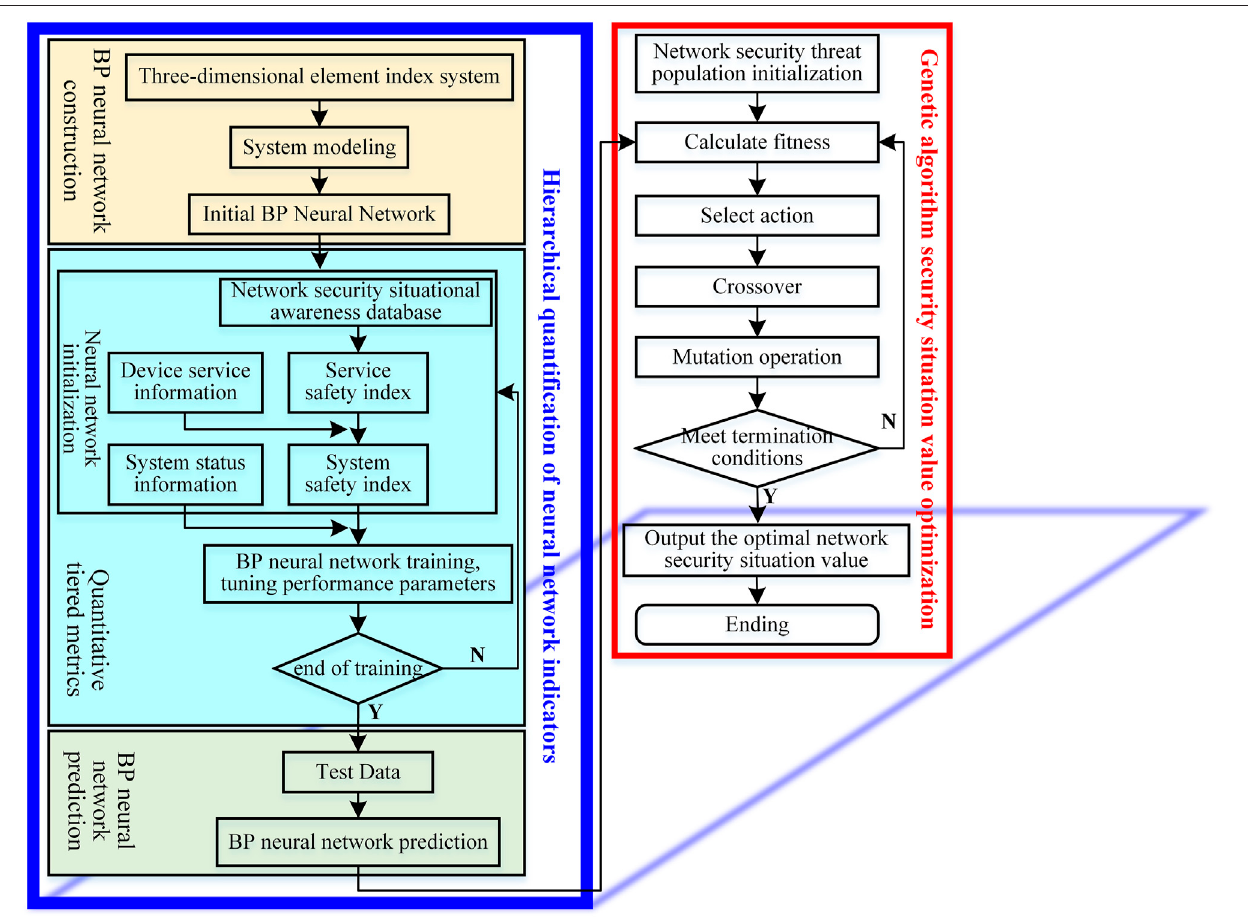
FIGURE 2 | Quantitative model of the power information network security